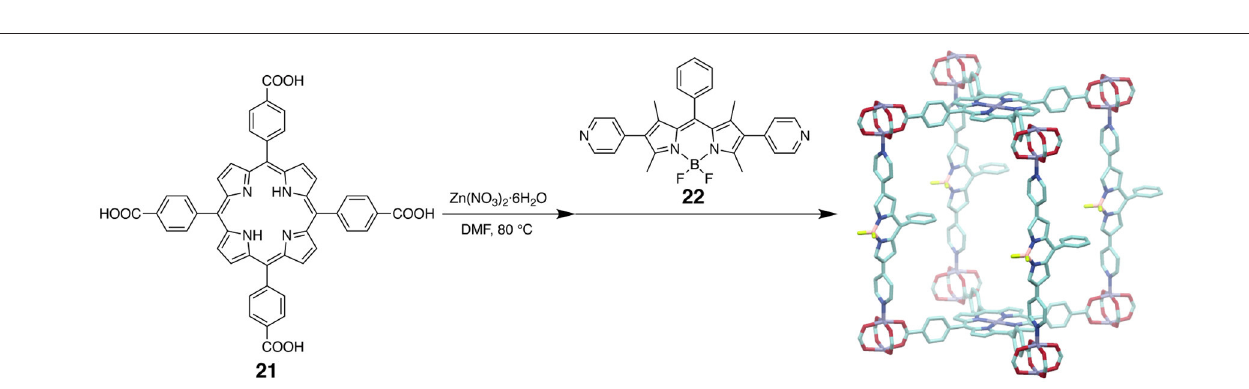
FIGURE 12 | Schematic illustration showing the synthesis of a pillared-paddlewheel type MOF through reaction of 21 with Zn(II) ions followed by reaction with BODIPY 22 . The structure of the MOF is determined by X-ray crystallography. Hydrogen atoms and disordered solvents are omitted for clarity.